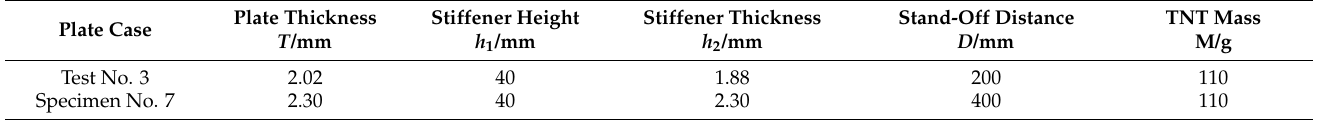
Table 3. Dimensions and loading condition of typical